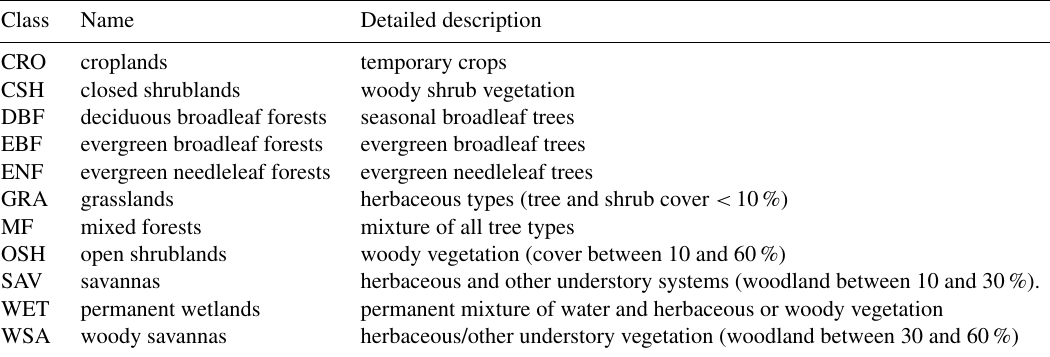
Table A1. Description of the plant functional type (PFT) classes of the ecosystems investigated in this study (according to the IGBP (Inter- national Geosphere-Biosphere Programme) vegetation classification scheme).